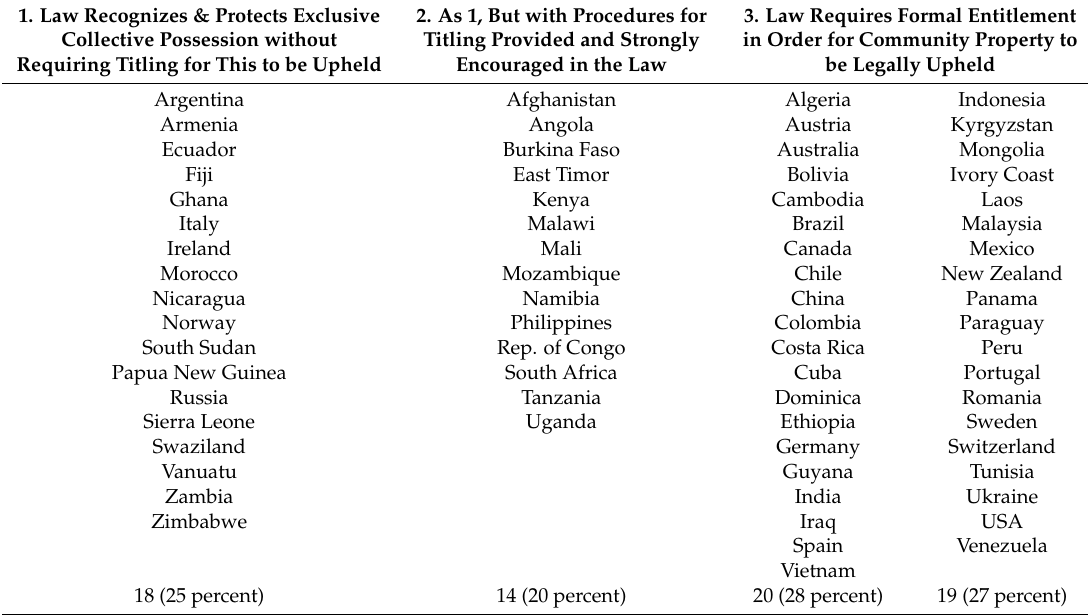
Table 9. Formalization as the Route to Recognition of Community Property in Sample of 71